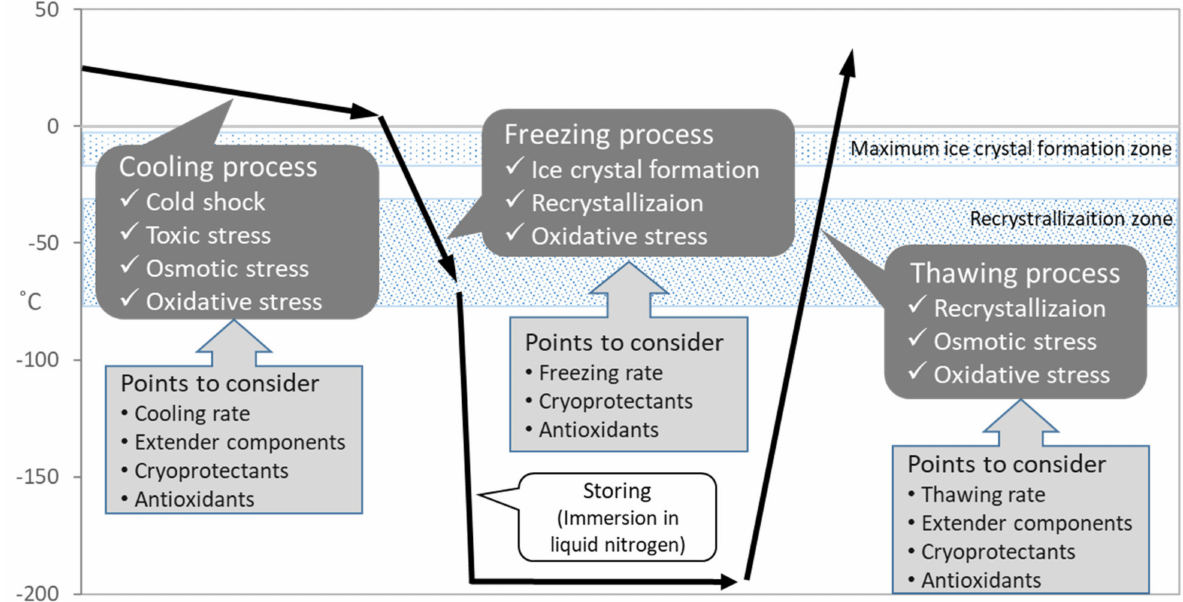
Figure 2. Schematic diagram of temperature changes during sperm cryopreservation process and associated